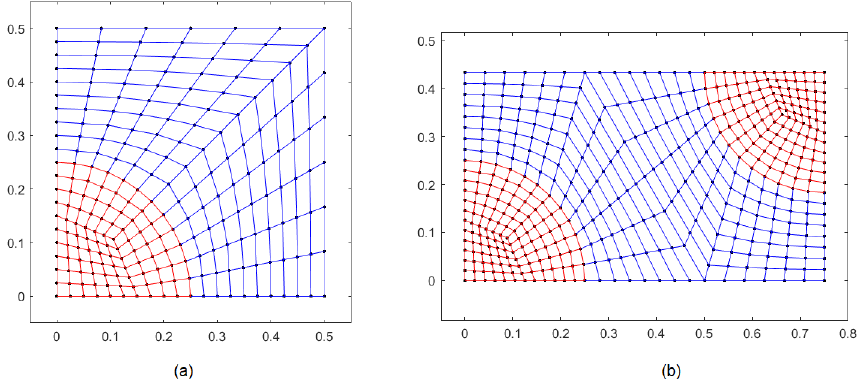
Figure 3. 4-node quadrilateral meshes: ( a ) square cell distribution, ( b ) hexagonal cell